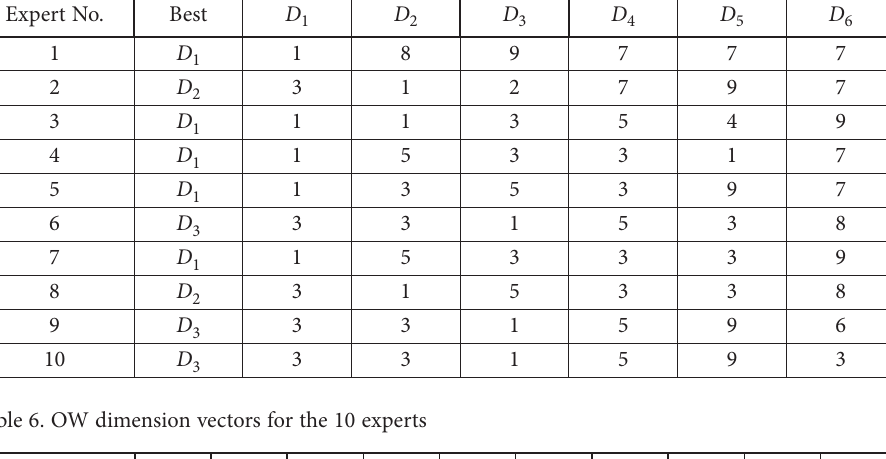
Table 5. BO dimension vectors for the 10 experts Expert No.